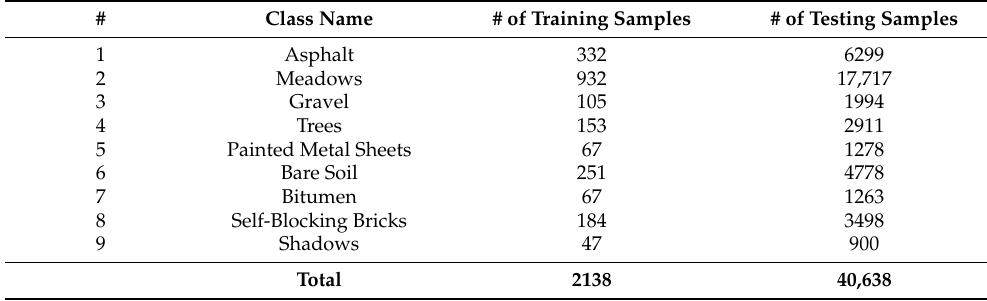
Table 2. Total number of class-specific training and testing samples used for Pavia University dataset for 5% training data.